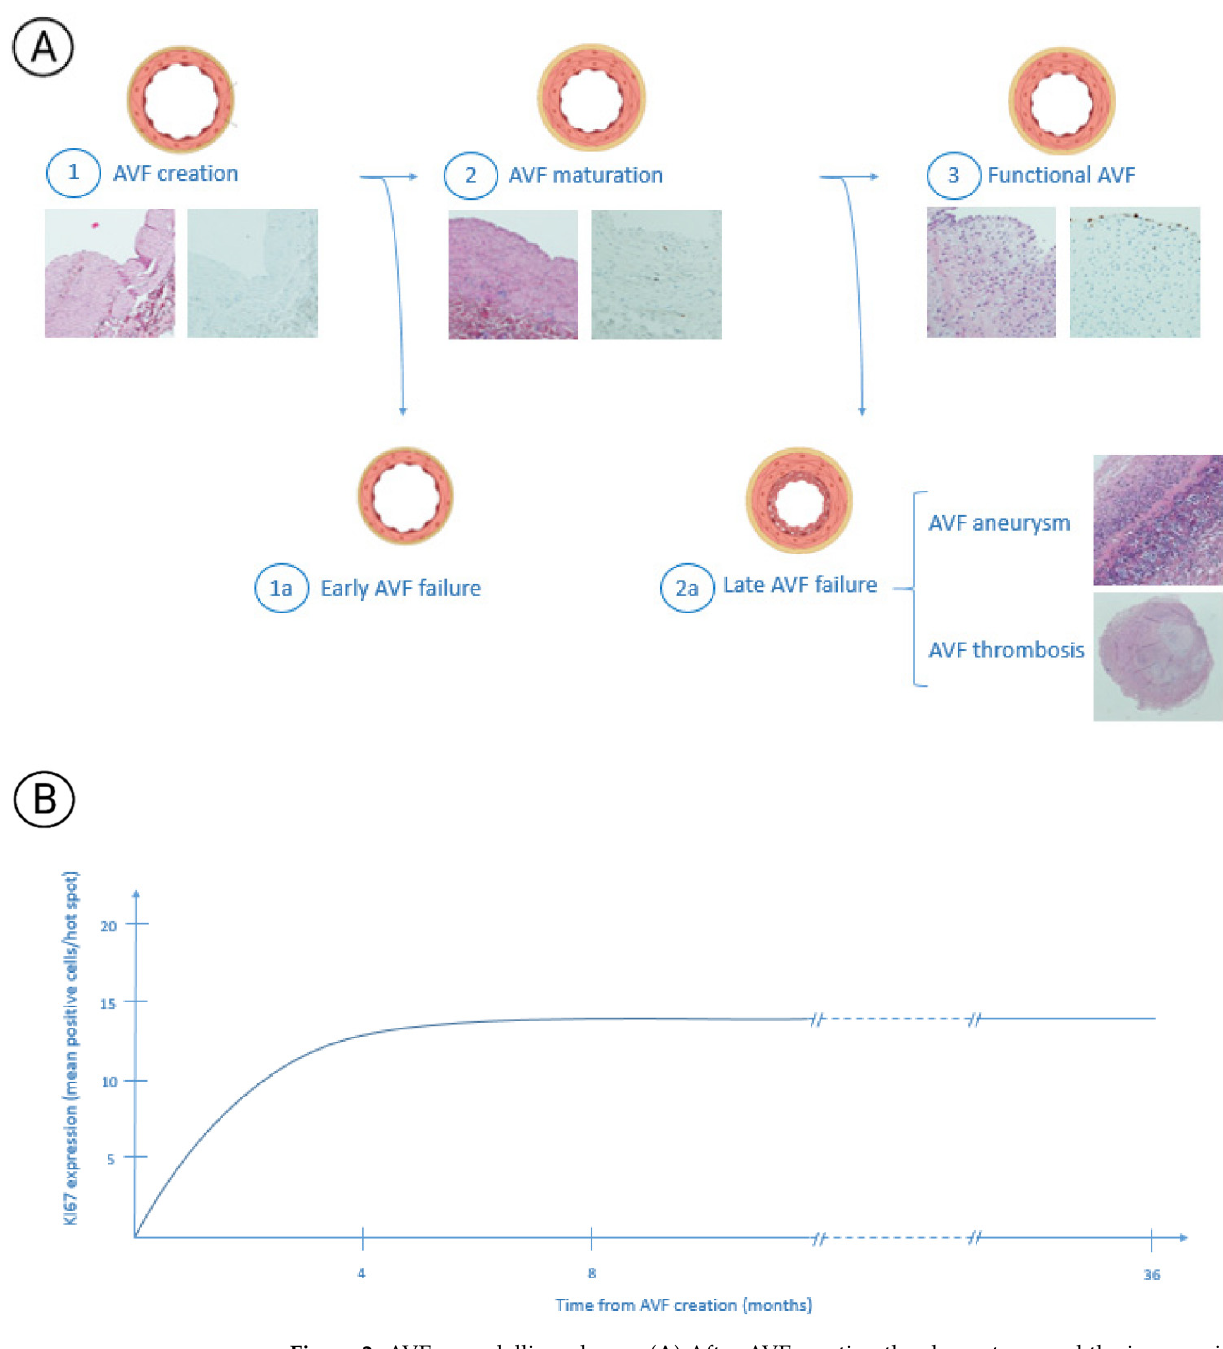
Figure 2. AVF remodelling phases. ( A ) After AVF creation the shear stress and the increase in the venous radial force triggers efferent vein remodelling. In this figure are shown the different phases of this process. The first part of the image shows a normal vein wall (1) that undergoes a maturation process called “arterialization” that leads to myointimal hypertrophy (2). This phenomenon allows for obtaining a mature AVF useful to HD (3). Unfortunately, sometimes this process does not begin or its entity is too poor to develop a usable AVF (1a) or, during the time, it leads to excessive hypertrophy which can result in AVF aneurysm or thrombosis with subsequent AVF failure. Figure 2a shows that histologic stains are obtained by haematoxylin–eosin and immunohistochemistry preparation. All the images were realized by a 10x magnification [12]. ( B ) The figure shows KI67 expression months after AVF creation. It presents a trend of expression during the first 6–8 months from its creation until an expression plateau is achieved that persists during 36 months from AVF creation without important variations [12].